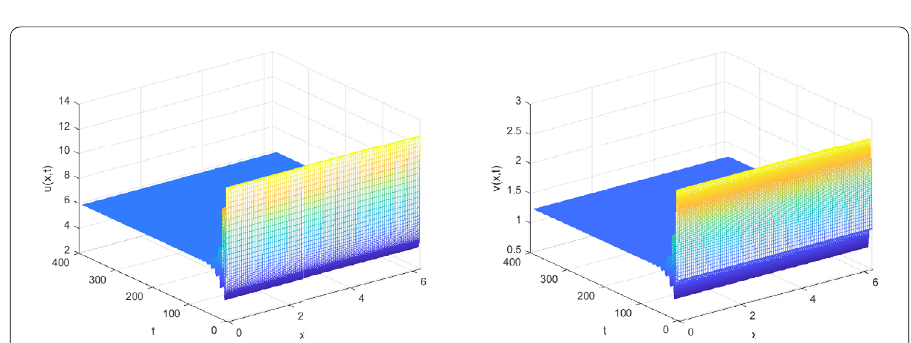
Figure 13 τ = 3.9, β = 0.68 and the initial condition is (12.71,1.17). P ∗ = ( u ∗ , v ∗ ) is locally asymptotically